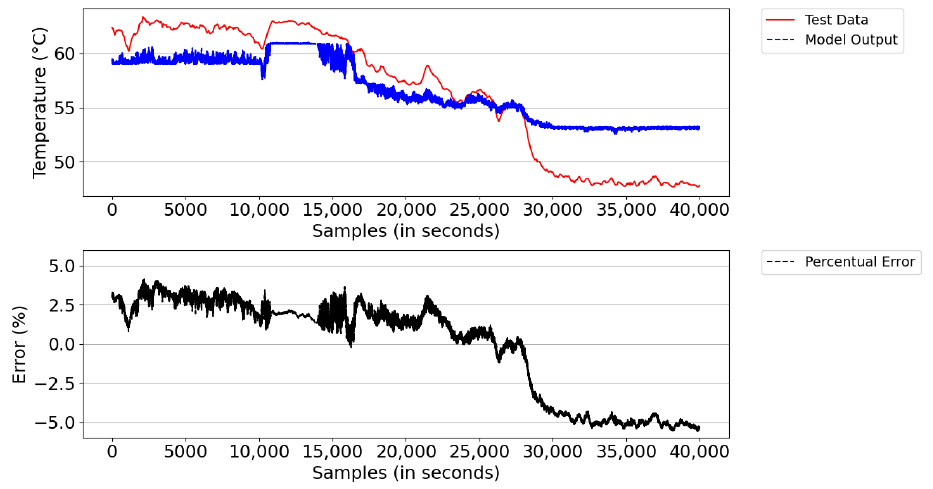
Figure 16. Model result versus actual T out _ HT value and instantaneous percentage